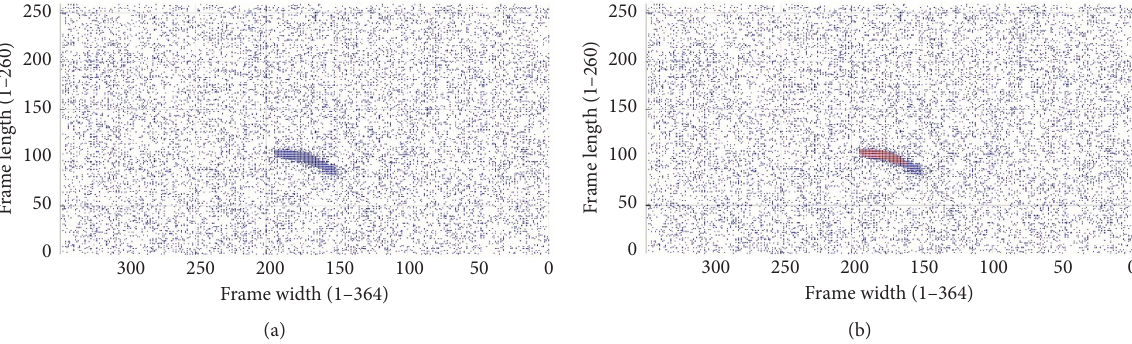
Figure 5: Event stream marked with object events compared with raw event stream. The event stream marked with the target event basically covers the location of the target and the shape of the target. (a) Raw event stream. (b) Event stream marked with object events.